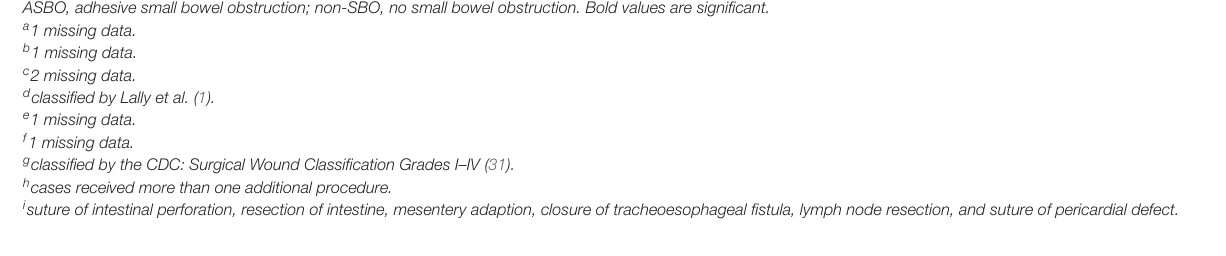
TABLE 6 | Differences in surgical characteristics and intraoperative findings between patients with ASBO and non-SBO. Timing of reconstruction in